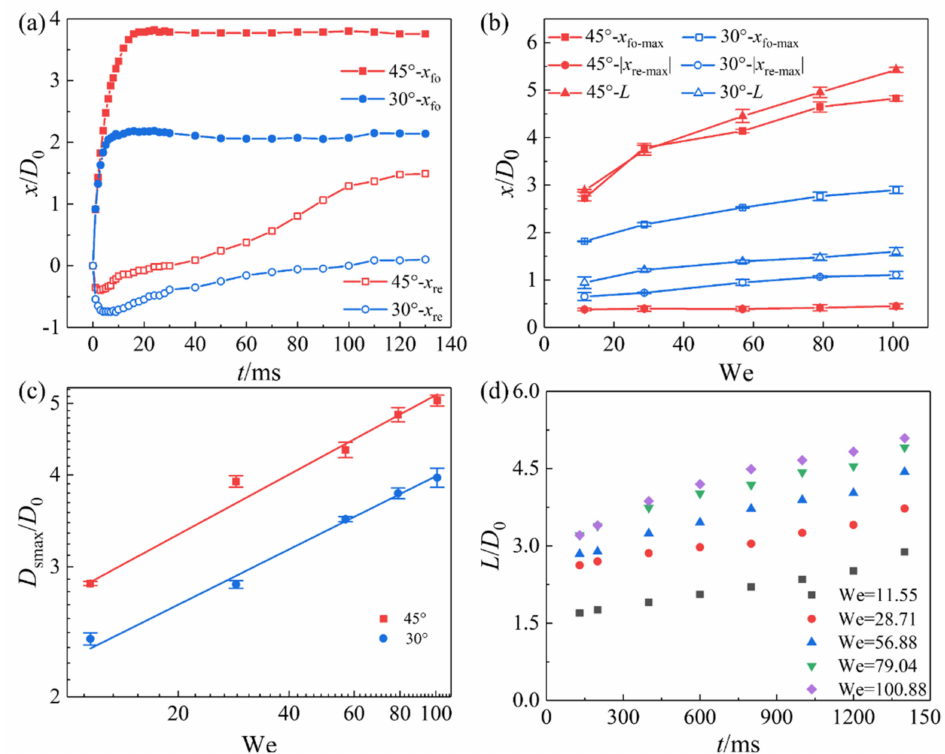
Figure 9. Effect of inclination angle and We number on the spreading and slipping of droplets on the ultra-slippery hydrophilic surface. ( a ) Displacement of the foremost point x fo and the rearmost point x re of the droplet over time t on the test surface with different inclination angles. ( b ) Effect of the We number on the maximum displacement of the foremost point x fo-max and the rearmost point | x re-max | of the droplet on the test surface with different inclination angles. ( c ) Variation in the maximum spreading diameter D smax as a function of the We number for the droplet impact on the test surface with different inclination angles. ( d ) Dimensionless slipping distance L / D 0 over time t with different We numbers on the